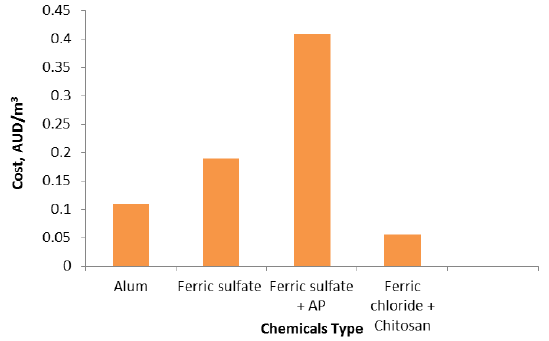
Figure 5. Chemical coagulant prices on the international market. Energies 2017 , 10 , 731 Table 18. Coagulants that have potential to be used in treating wastewater from the red meat processing industry.